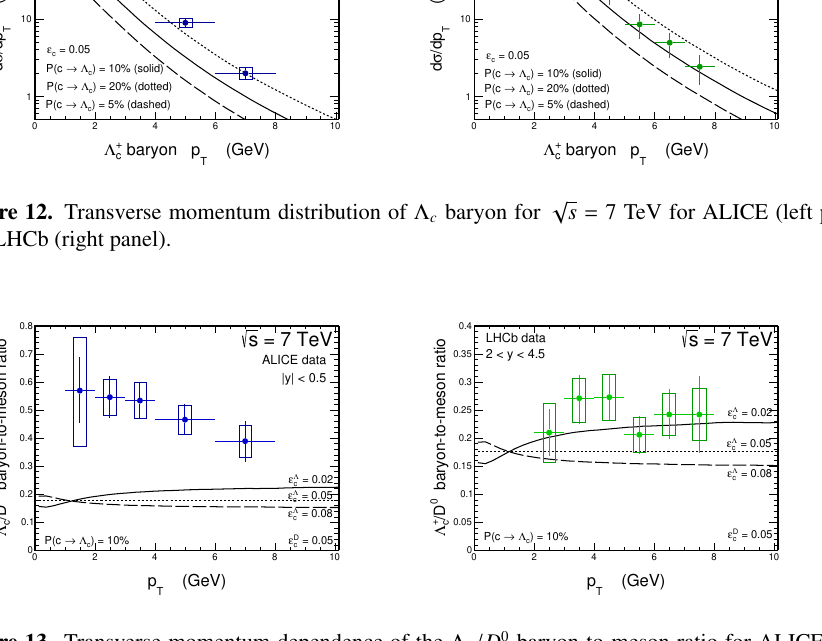
parameter for c → Λ c transition in the Peterson c